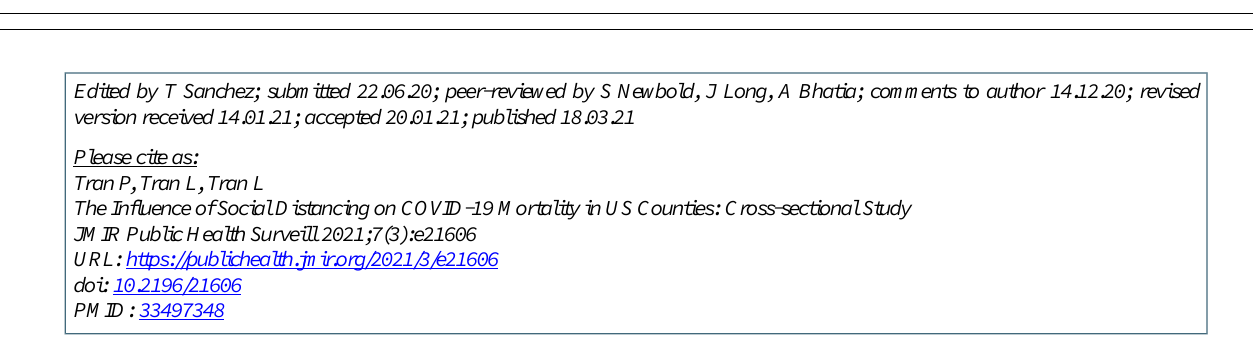
Abbreviations CDC: Centers for Disease Control and